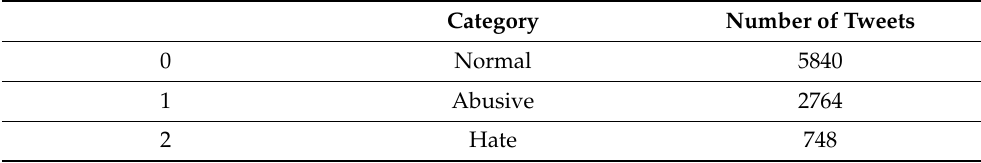
Table 2. Statistics of the datasets and labels.